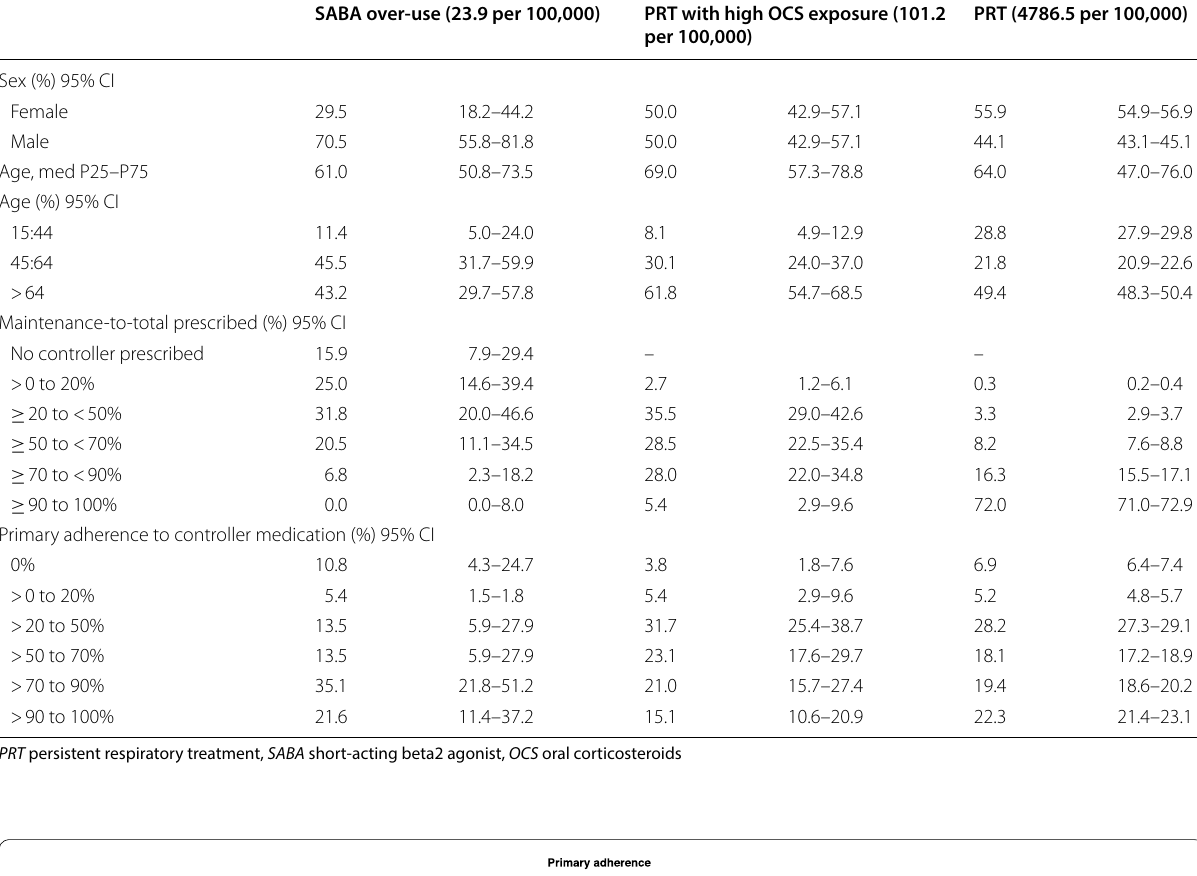
Table 1 Characteristics of patients on SABA over-use, on PRT with high OCS exposure, and on PRT